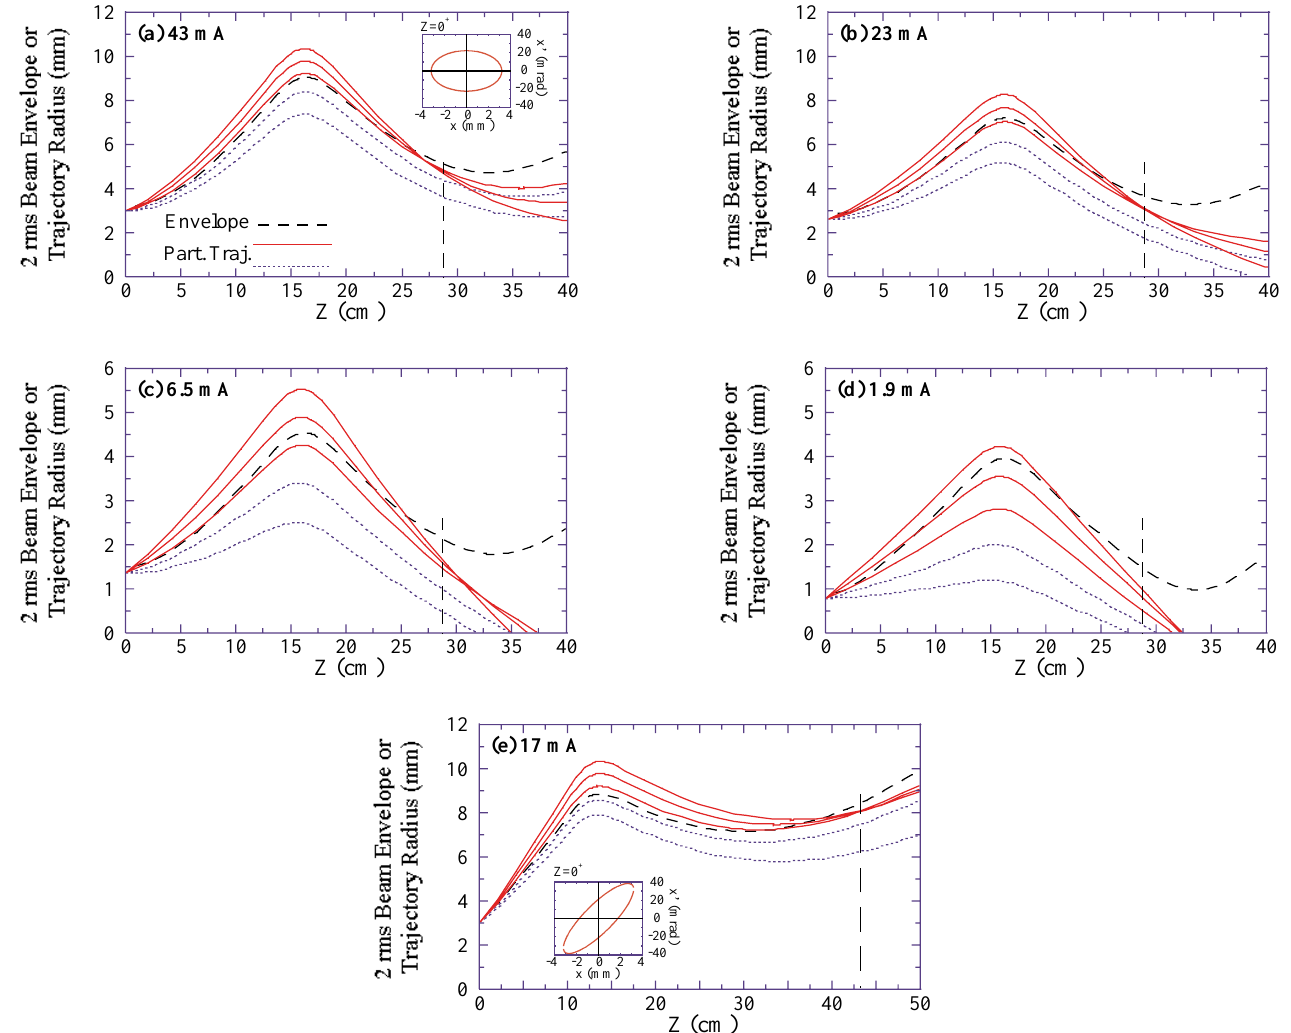
FIG. 5. (Color) Tracking of beam-edge particles [see Eqs. (1) and (2), and Table I]: (a)–(d) 5 keV electron beam from gridded gun; (e) 4 keV electron beam from a convergent-type gun. The vertical dashed line indicates one of the planes where phosphor screen pictures were taken (see Figs. 2). In (a)–(d) the initial slopes of particle trajectories are 0, 5, 10, 15, and 20 mrad; in (e) the initial slopes are 30, 35, 40, 45, and 50 mrad. The inserts in (a) and (e) show the equivalent KV ellipses at z (cid:1) 0 1 .